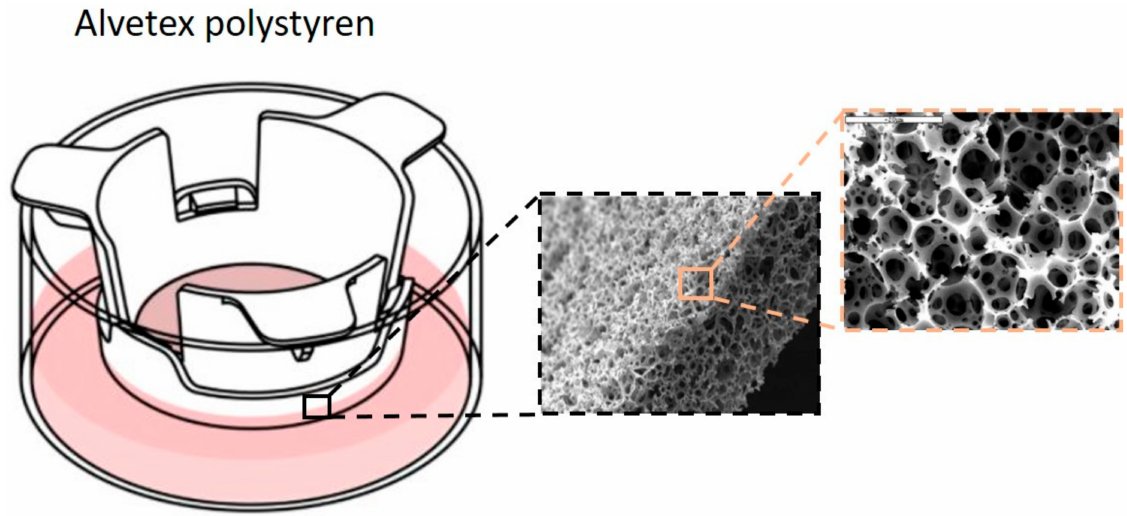
Figure 2. Polystyrene well insert holder for 3D culture Alvetex Scaffold (alvetex ®